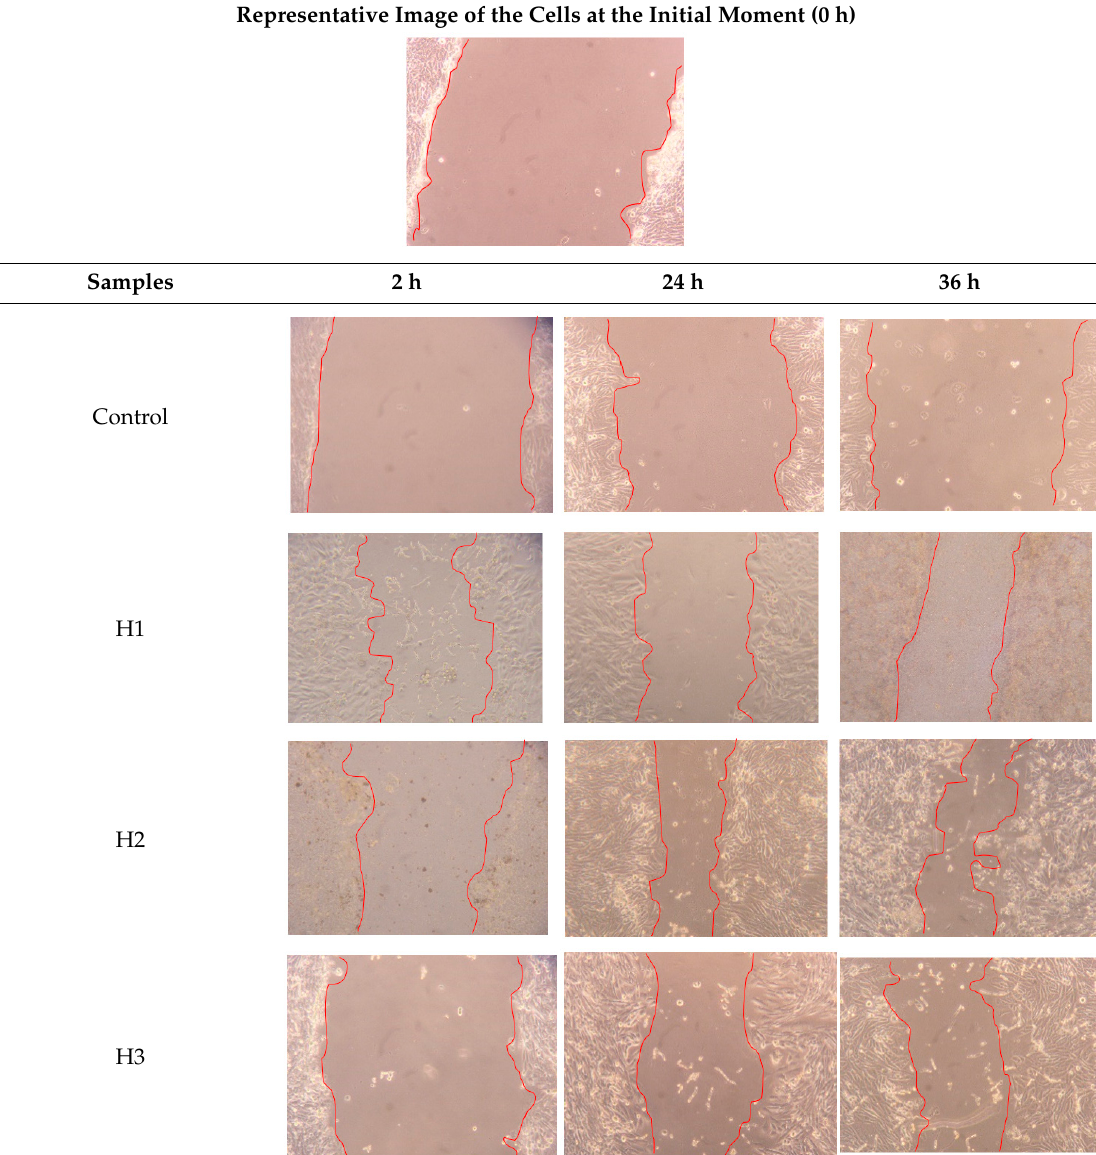
Table 3. Microscopic images obtained from the scratch wound-healing assay with the honeys (magnification: 100 × ). Representative Image of the Cells at the Initial Moment (0 h)